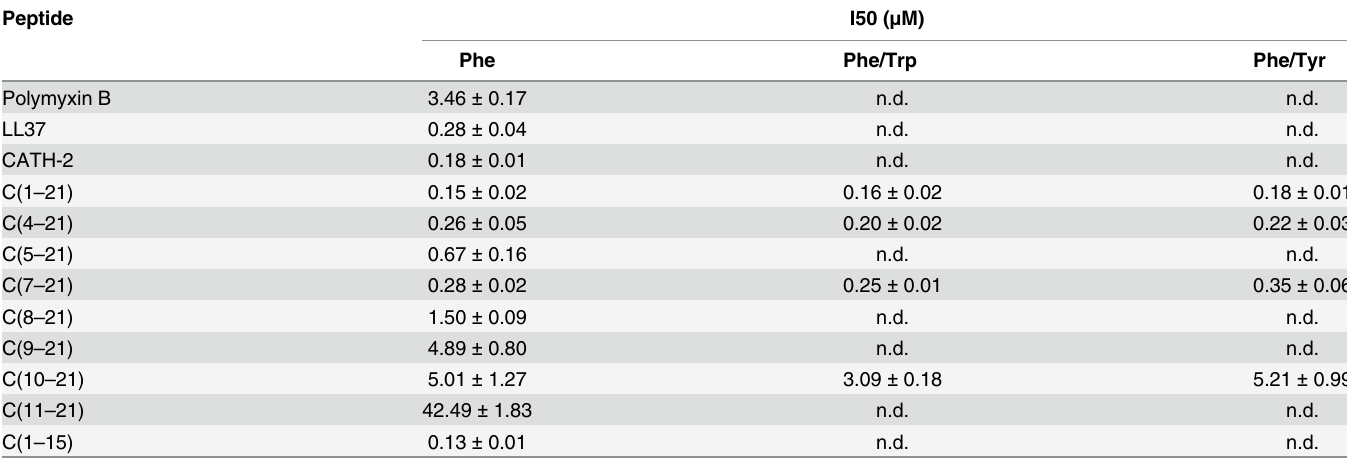
Table 4. LPS binding affinity of CATH-2 analogs. Peptide